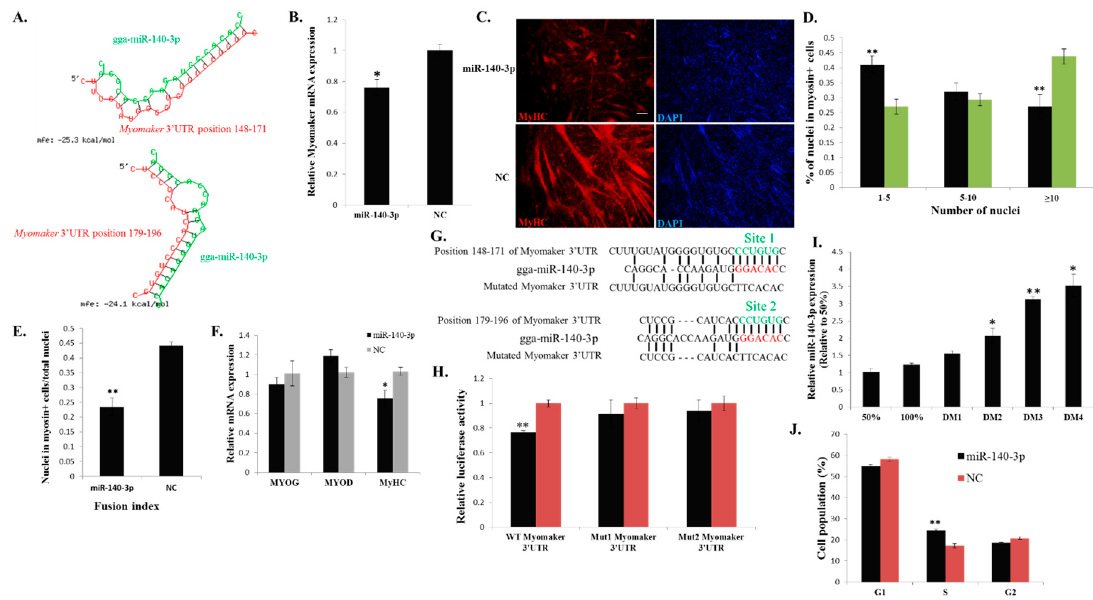
Figure 6. miR-140-3p directly binds to the 3 ʹ UTR of Myomaker and inhibits Myomaker expression and myoblast fusion. ( A ) Schematic representation of the duplexes of miR-140-3p and the Myomaker 3 ʹ UTR target region; ( B ) Myomaker mRNA expression after miR-140-3p mimic or NC duplexes transfection into DM2 myoblasts; ( C ) MyHC immunostaining of primary myoblasts transduced with miR-140-3p mimic or NC duplexes and differentiated for 48 h. Bar, 100 µm; ( D ) The distribution of myonuclear content in the cells with transfection of miR-140-3p mimic or NC duplexes; ( E ) The fusion index of the cells transfected with miR-140-3p mimic or NC duplexes; ( F ) The mRNA expression of MYOG , MYOD and MyHC after transfection of miR-140-3p mimic or NC duplexes in DM2 myoblasts; ( G ) Schematic representation of the predicted binding sites (green) and mutated sites of miR-140-3p in the 3 ʹ UTR of Myomaker ; ( H ) Myomaker 3 ʹ UTR wild-type or mutant luciferase reporters were transfected into DF-1 cells overexpressing miR-140-3p mimic or NC duplexes. Luciferase activity was determined at 36 h after transfection; ( I ) miR-140-3p expression during myoblast differentiation; ( J ) Cell cycle analysis of myoblasts at 36 h after miR-140-3p mimic or NC duplexes transfection. The results are shown as the mean ±S.E.M. of at least three cultures ( n = 3 cultures in D , E and J ; n = 4 cultures in B , F , H and I ). One-sample t test was used to assess the change from each data point to the control (50% in I ). * p < 0.05; ** p < 0.01.